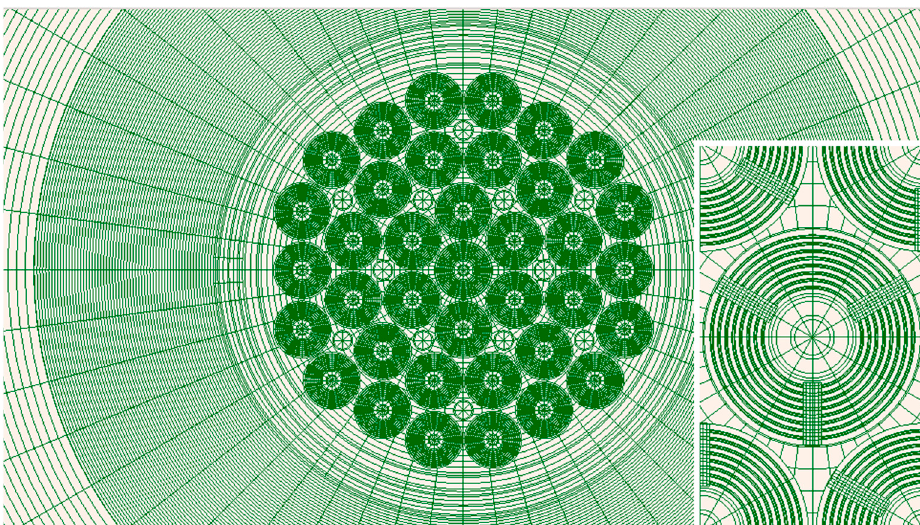
Figure 6. Jules Horowitz Research Reactor radial cut and unit cell by ALAMOS.